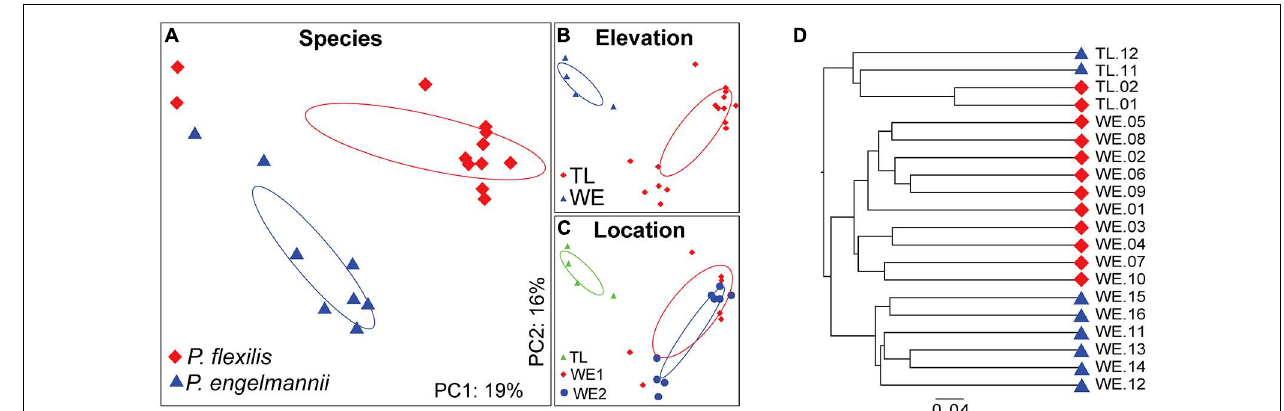
FIGURE 6 | PCoA and UniFrac analysis of the bacterial communities associated with conifer needles. (A–C) PCoA of the unweighted UniFrac distance matrix. Points that are closer together on the ordination have communities that are more similar. Each point corresponds to a sample, and